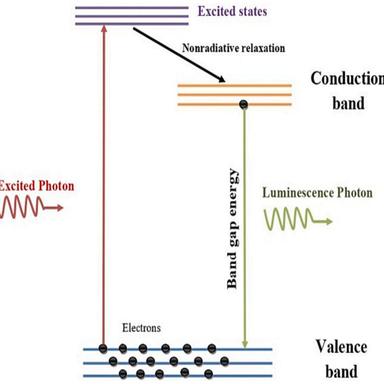
Schematic representation of mechanism of Photoluminescence.